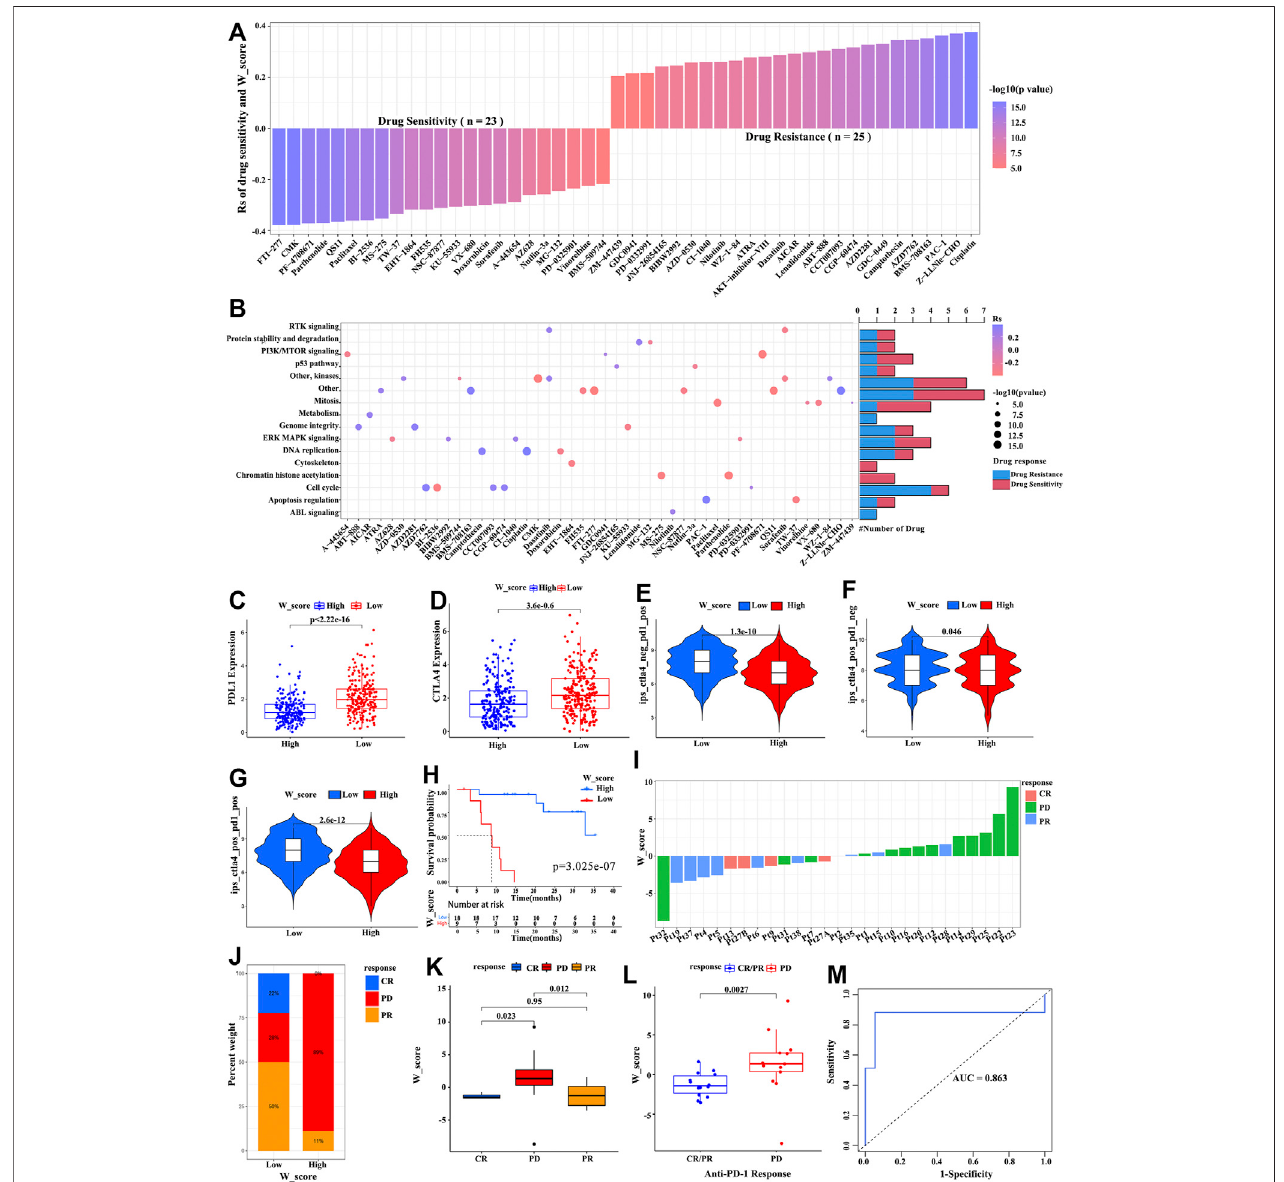
FIGURE 6 | The W_Score predicting the drug sensitivity and immunotherapy ef fi cacy. (A) The association between W_Score and drug sensitivity (Spearman analysis). (B) Signaling pathways targeted by drugs that are resistant (red) or sensitivity (blue) to the W_Score. (C,D) Differences in expressions of PD-L1 and CTAL-4 between high- and low- W_Score groups (Wilcoxon test; p < 0.0001). (E – G) The correlation between co-expression of PD-L1 and CTLA-4 and the W_Score (samples with SKCM from TCGA), including CTAL-4 positive and PD-1 negative (ips_ctla4_pos_pd1_neg) (E) , CTAL-4 positive and PD-1 positive (ips_ctla4_pos_pd1_pos) (F) , and CTAL-4 negative and PD-1 positive (ips_ctla4_neg_pd1_pos) (G) . (H) Kaplan-Meier curve showing overall survival of SKCM patients between high- and low- W_Score groups in the anti-PD1 immunotherapy cohort (GSE78220 cohort; Log-rank test; p < 0.001). (I) The relationship of W_Score with clinical response to PD-1 blockade immunotherapy (GSE78220 cohort). (J) The proportion of patients with response to anti-PD-1 immunotherapy in high and low W_Score groups (GSE78220 cohort). PD, progressive disease; CR, complete response; PR, partial response. (K,L) The differences in the W_Score among distinct PD-1 blockade immunotherapy response groups (GSE78220 cohort). (M) The predictive value of W_Score in SKCM patients treated with anti-PD-1 immunotherapy (GSE78220; AUC, 0.863).